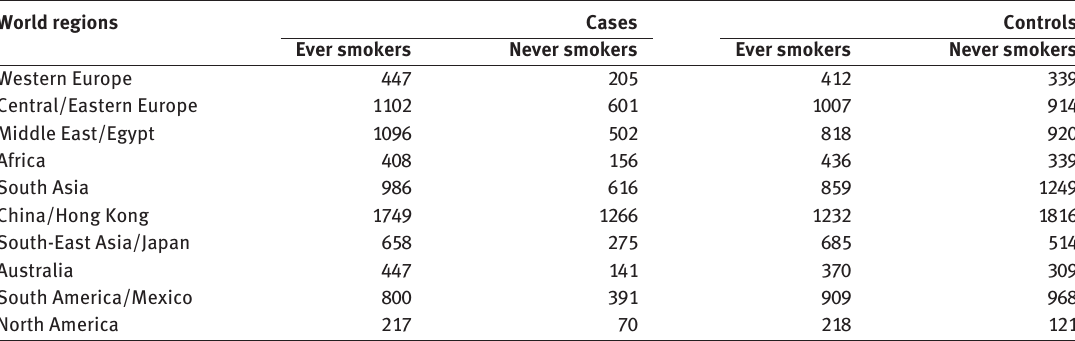
Table 3: Data from the INTERHEART study [33, 34].